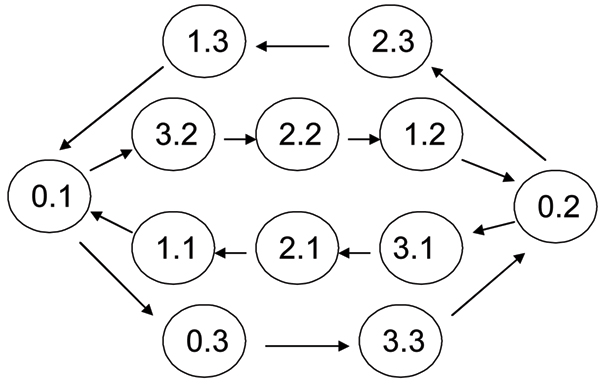
Looped hybridization scheme for analysis of liver and hepatic cell transcriptional responses. Circles represent treatment samples. For liver tissue samples, 0.x = solvent control biological replicate x, 1.x = 12 mg/kg dose biological replicate x, 2.x = 24 mg/kg dose biological replicate x, 3.x = 48 mg/kg dose biological replicate x. For 24 and 48 hr exposures of primary hepatic cells to RDX, 0.x = solvent control biological replicate x, 1.x = 7.5 mg/L dose biological replicate x, 2.x = 15 mg/L dose biological replicate x, 3.x = 30 mg/L dose biological replicate x. Arrows represent array hybridizations between respective samples where the arrowhead indicates dye labelling with Alexa 647 and the base of arrows indicate dye labelling with Cy3.